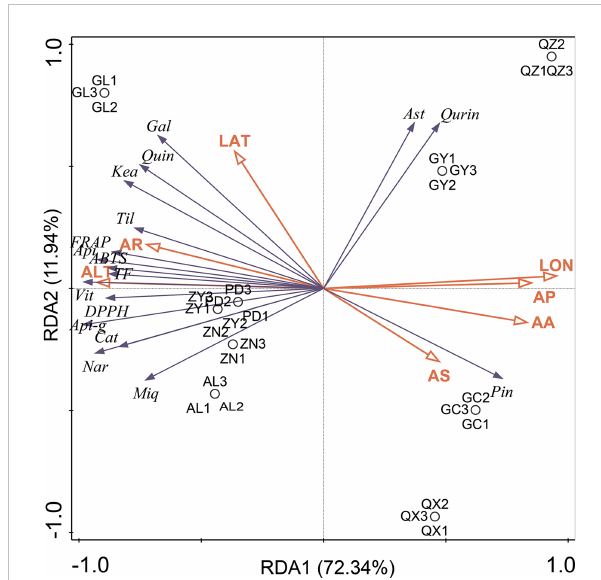
FIGURE 7 Results of RDA analysis presenting the correlation between fl avonoid markers and antioxidant activities and ecogeographic parameters in each sample. Seven ecogeographic parameters were studied: (ALT), longitude (LON), latitude (LAT), average precipitation (AP), temperature (AA), sunshine (AS) and relative humidity (AR). 13 fl avonoid markers were included: (-)-catechin (Cat), naringenin chalcone (Nar), apigenin-7-glucuronide (Api-g), apigenin (Api), vitexin (Vit), miquelianin (Miq), tiliroside (Til), and (-)-gallocatechin (Gal), keampferol (Kea), quercetin (Quin), astragalin (Ast), quercitrin (Qurin), pinocembrin